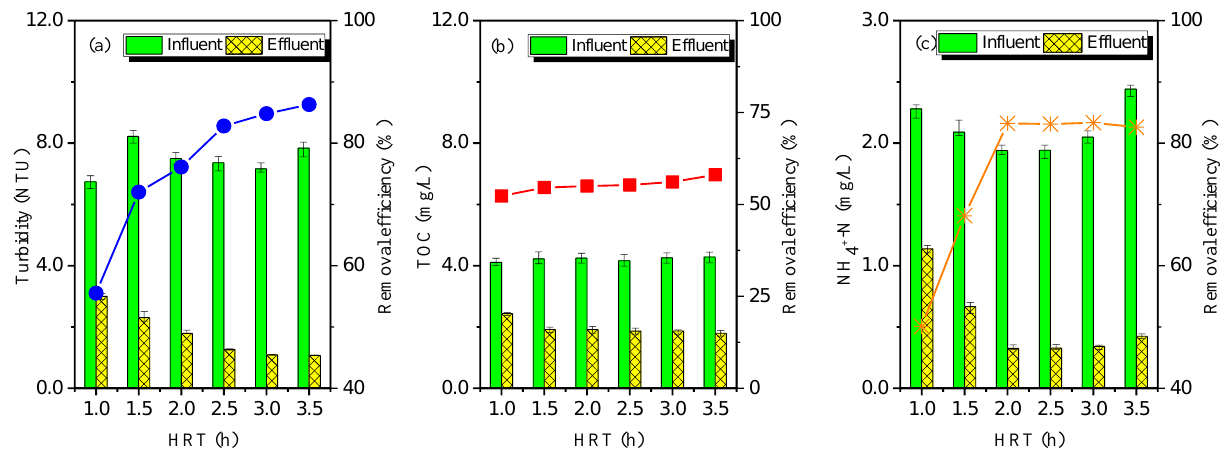
Figure 4. Effects of HRT on the removal of turbidity ( a ), TOC ( b ), and NH + 4 -N polluted water with the modified settling tank (organic loading rate = 0.35 g/(m 2 ∙d) and disc rotating speed = 3.0 r/min).